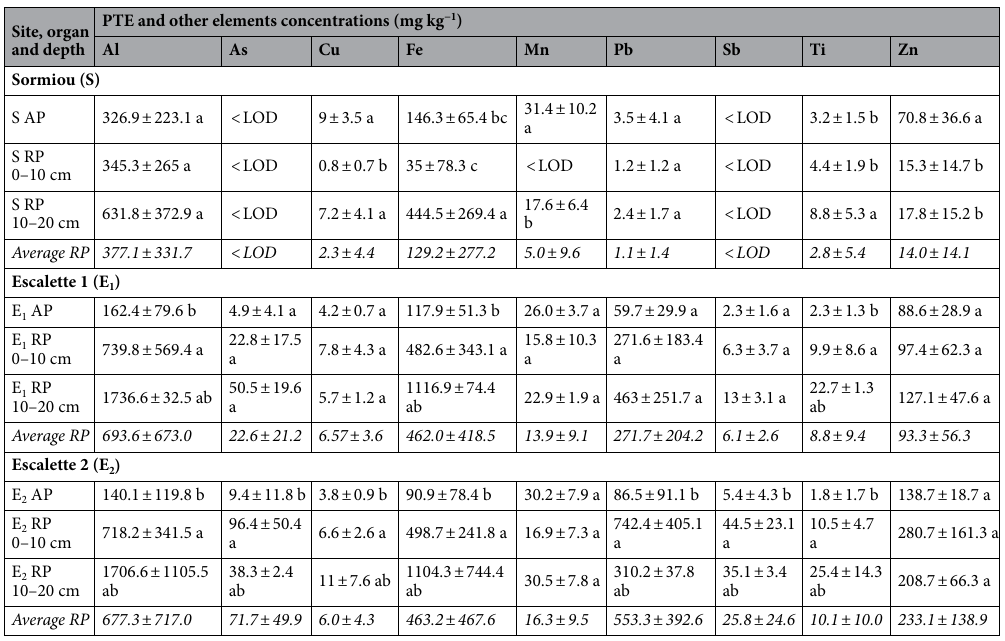
Table 4. PTE and other element concentrations measured in the aerial parts (AP) ant root parts (RP) of the individuals of Coronilla juncea at the different sites (S, E 1 , E 2 ) and soil depths. The average root part concentrations (in italics) have been calculated using mean concentrations and root biomasses per depth. For a same element and a same site, different letters indicate a significant difference between sites, organs and/or depths (Wilcoxon test, p-value ≤